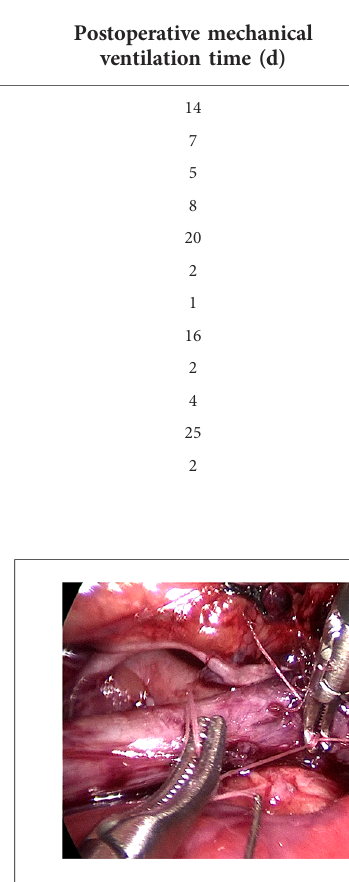
FIGURE 1 An auxiliary clamp can be positioned at the 5th intercostal gap of the subscapular angle.